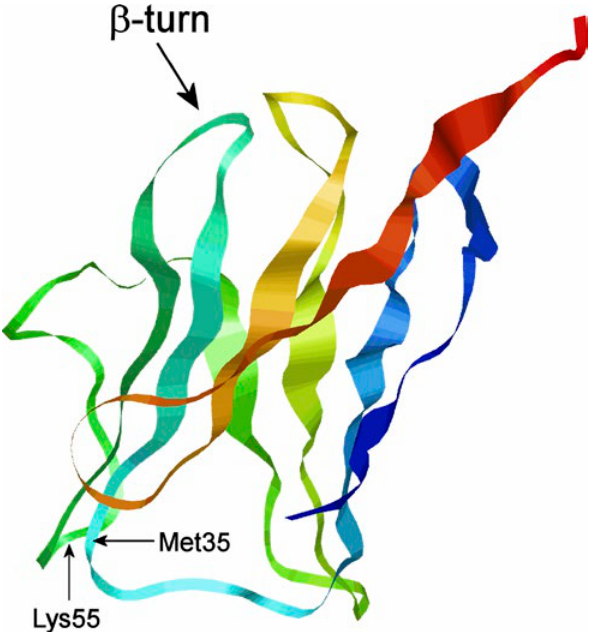
Figure 1. Homology model of the extracellular domain of human myelin oligodendrocyte glycoprotein (MOG), with the β-turn inside the fragment MOG(35-55)